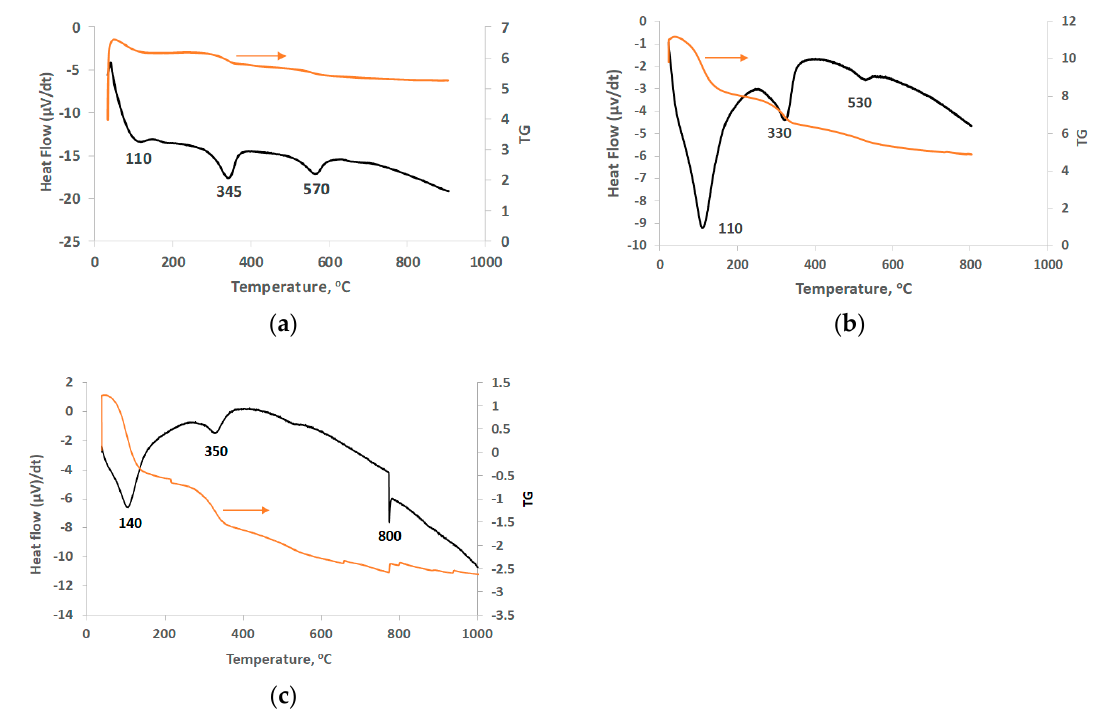
Figure 4. DSC/TG curves of ( a ) LAI, ( b ) residue after leaching with 1.5 M H 2 SO 4 , and ( c ) residue after leaching with 1.5 M H 2 SO 4 with 20 g/L Na 2 SO 3 .